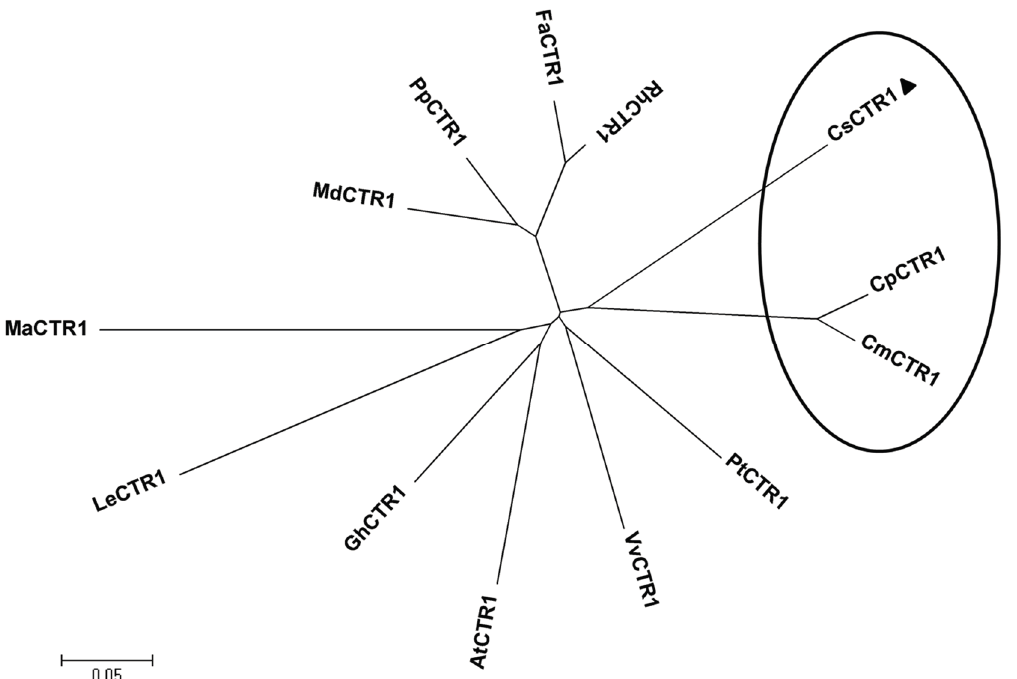
Figure 3. Phylogenetic relationships of known CTR1 in plants. Amino acid sequences used for alignment include Cucumis melo (CmCTR1, ADV92636), Vitis vinifera (VvCTR1, XP_002277360), Cucurbita pepo (CpCTR1, ADB55631), Prunus persica (PpCTR1, ACR23642), Malus × domestica (MdCTR1, ABI58290), Rosa hybrid cultivar (RhCTR1, AAK40361), Fragaria × ananassa (FaCTR1, AFI38955), Gossypium hirsutum (GhCTR1, ACZ66010), Populus trichocarpa (PtCTR1, XP_002326245), Solanum lycopersicum (LeCTR1, AAL87456), Arabidopsis thaliana (AtCTR1, CAB82938), Musa acuminata (MaCTR1, AFA37962) and Cucumis sativus (CsCTR1, AEZ53932). The scale bar represents the estimated evolutionary distance as 0.05 amino acid substitutions per site. CsCTR1 (indicated with black triangles) is grouped together with counterparts from melon (CmCTR1) and pumpkin (CpCTR1), as indicated by the